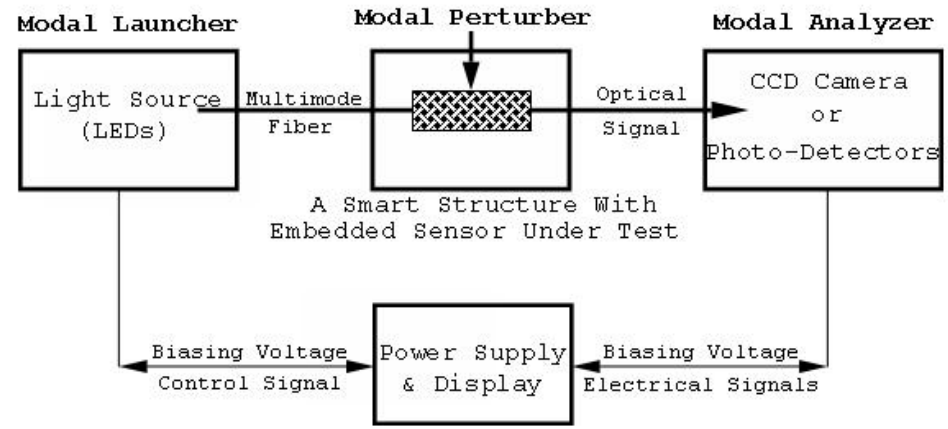
Figure 7. The general block diagram of the developed characterization method.